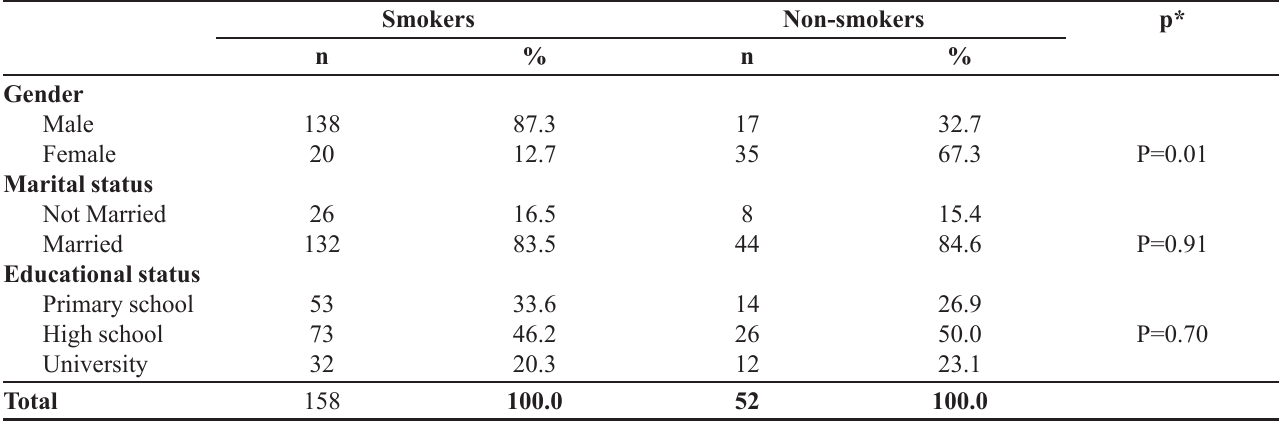
TABLE I - Some socio - demographic features of the smokers and non-smokers